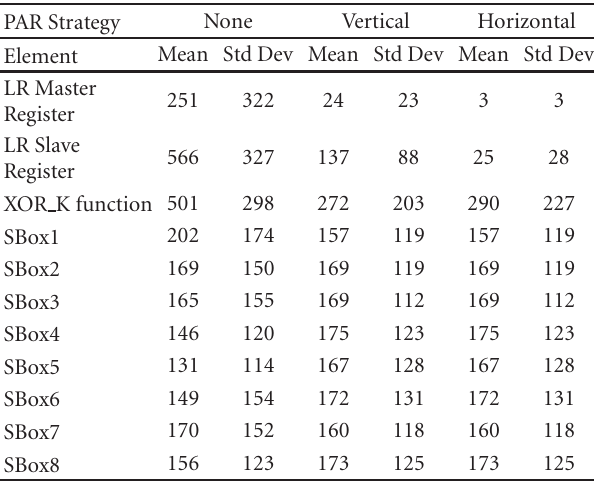
Table 2: Static evaluation of timing imbalance, in